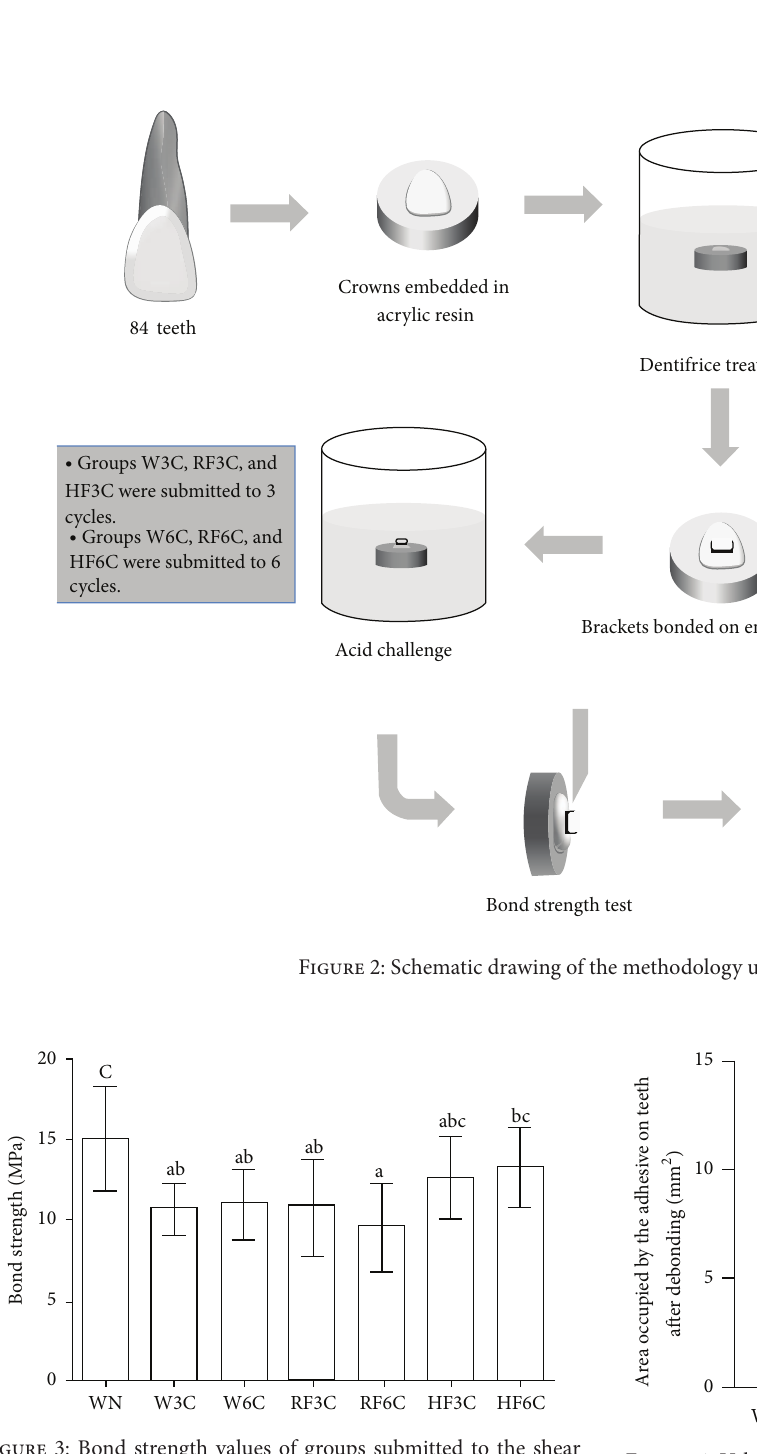
Figure 4: Values in mm 2 of adhesive material bonded to the tooth after debonding of brackets. Different letters indicate statistical difference (Kruskal-Wallis and post-hoc Dunn’s tests, 𝑃 < 0.05